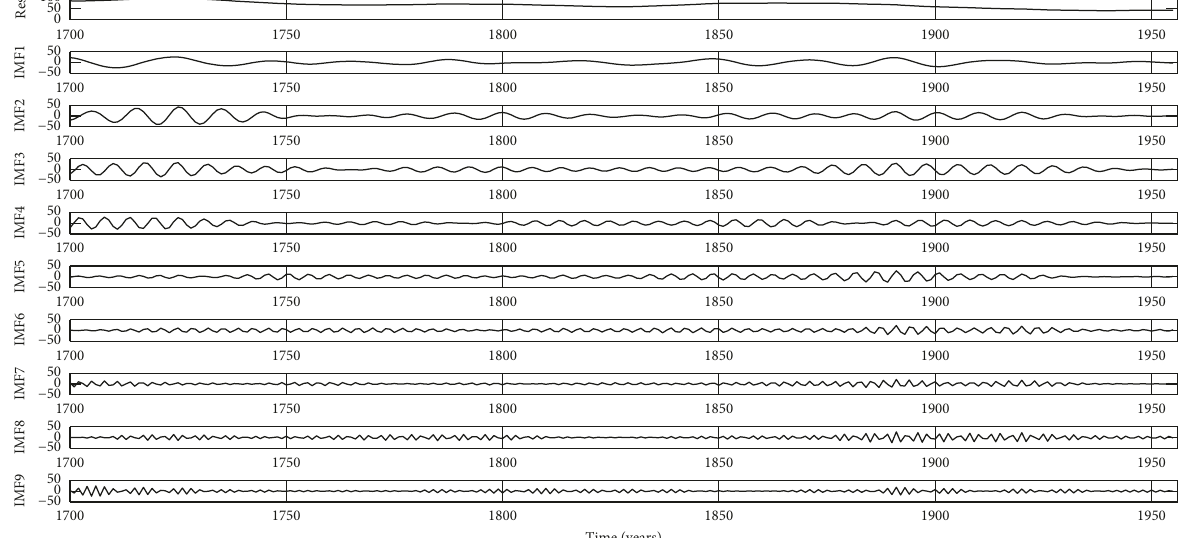
Figure 3: IMF components of tree ring width.